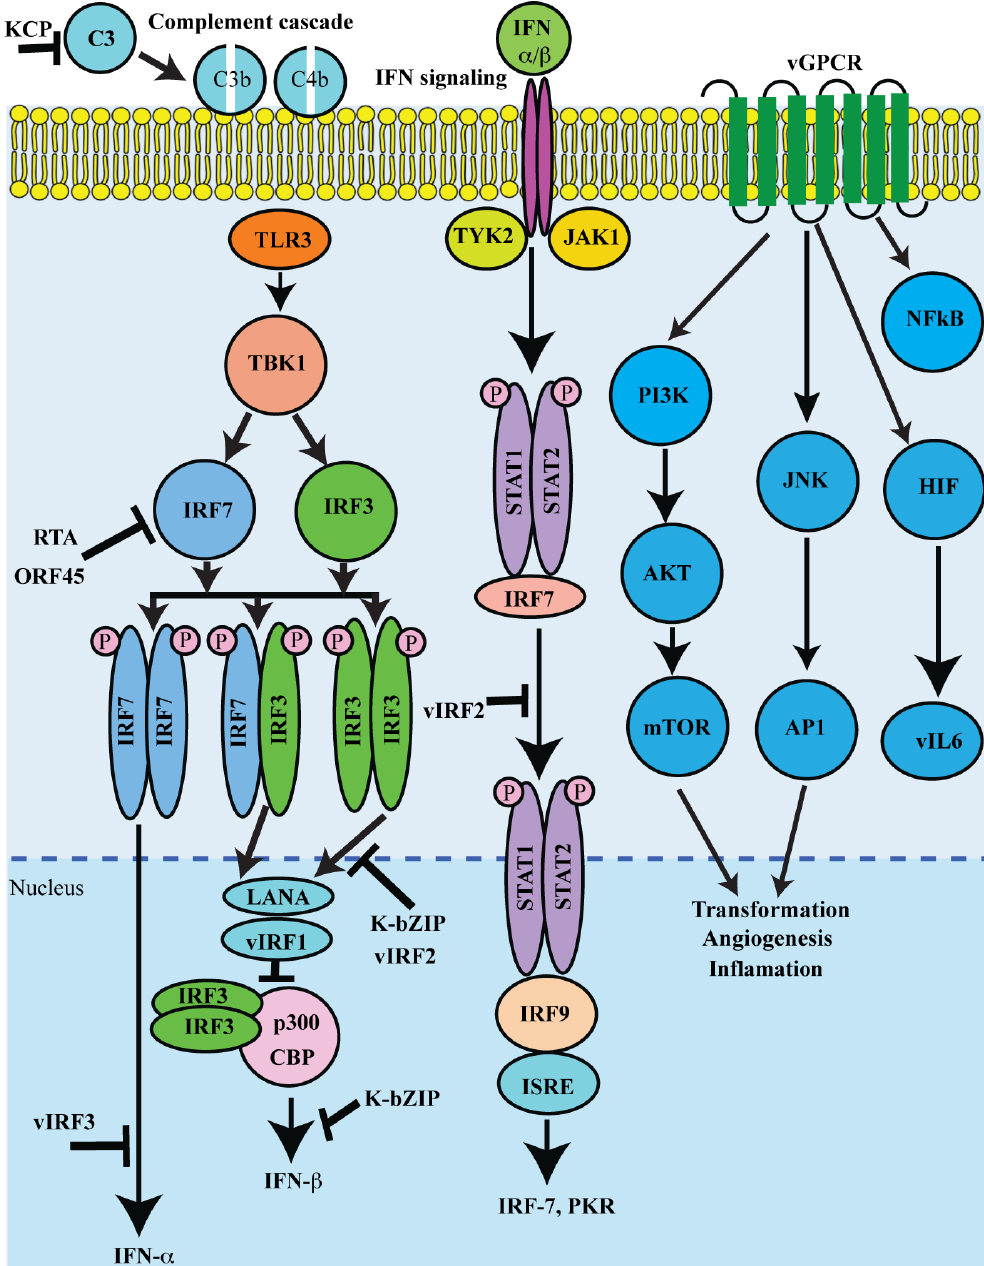
Figure 3. Schematic representation of lytic proteins in immune regulation and pathogenesis: The major immune functions targeted by viral lytic proteins include IFN production, interferon regulatory factor (IRF) activation, complement activation, inflammasome and chemokine activation. Regulating both IFN production and signaling is a potent antiviral defense, vIRF can bind and disrupt the transcriptional activities of IRF1, IRF3, and IRF7. Additionally, vGPCR is a constitutively active homologue of the IL8 receptor. vGPCR activates various cell signaling pathways and transcription factors to enhance the production of pro-inflammatory chemokines and cytokines, such as vIL-6. Furthermore, KSHV-encoded KCP regulates complement by increasing the decay of the classical C3